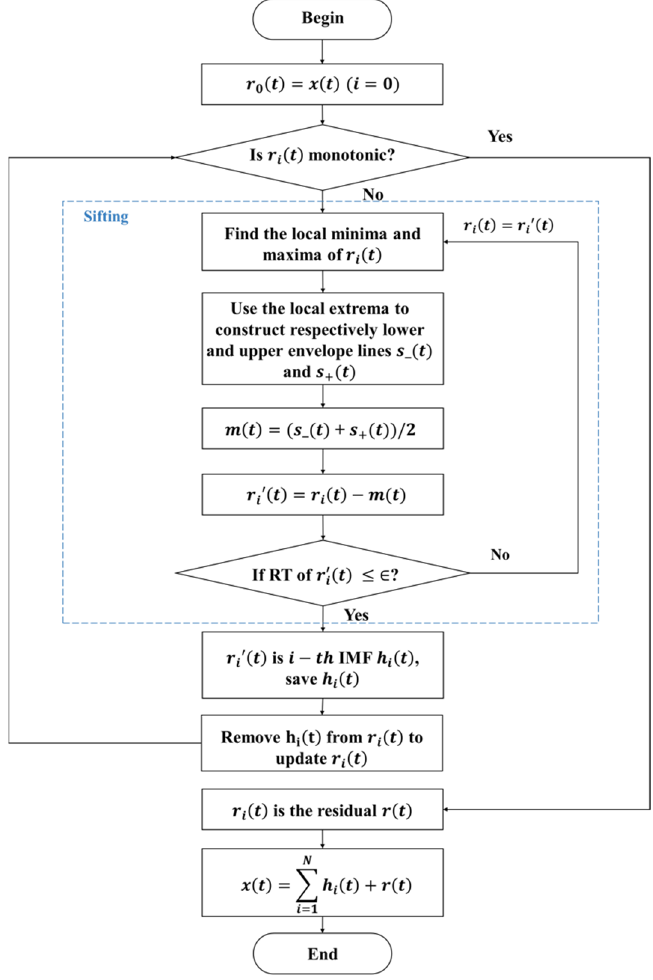
Figure 1. The process of EMD.